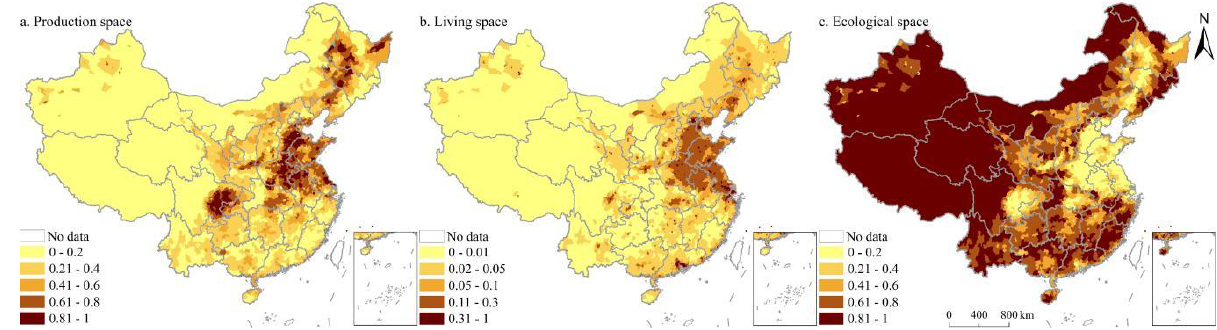
Figure 3. Spatial distribution of PLES at county level in China in 2020.